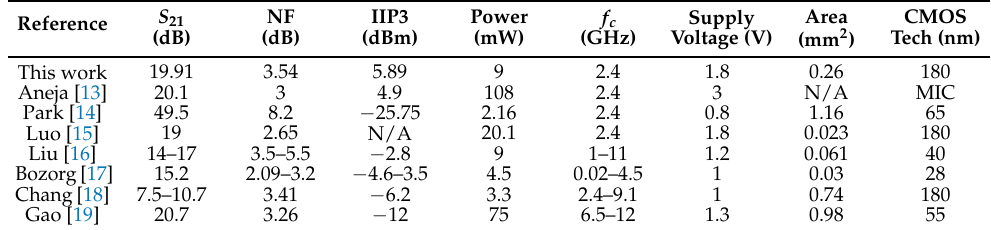
Table 2. A comparison table of the LNA and other works.